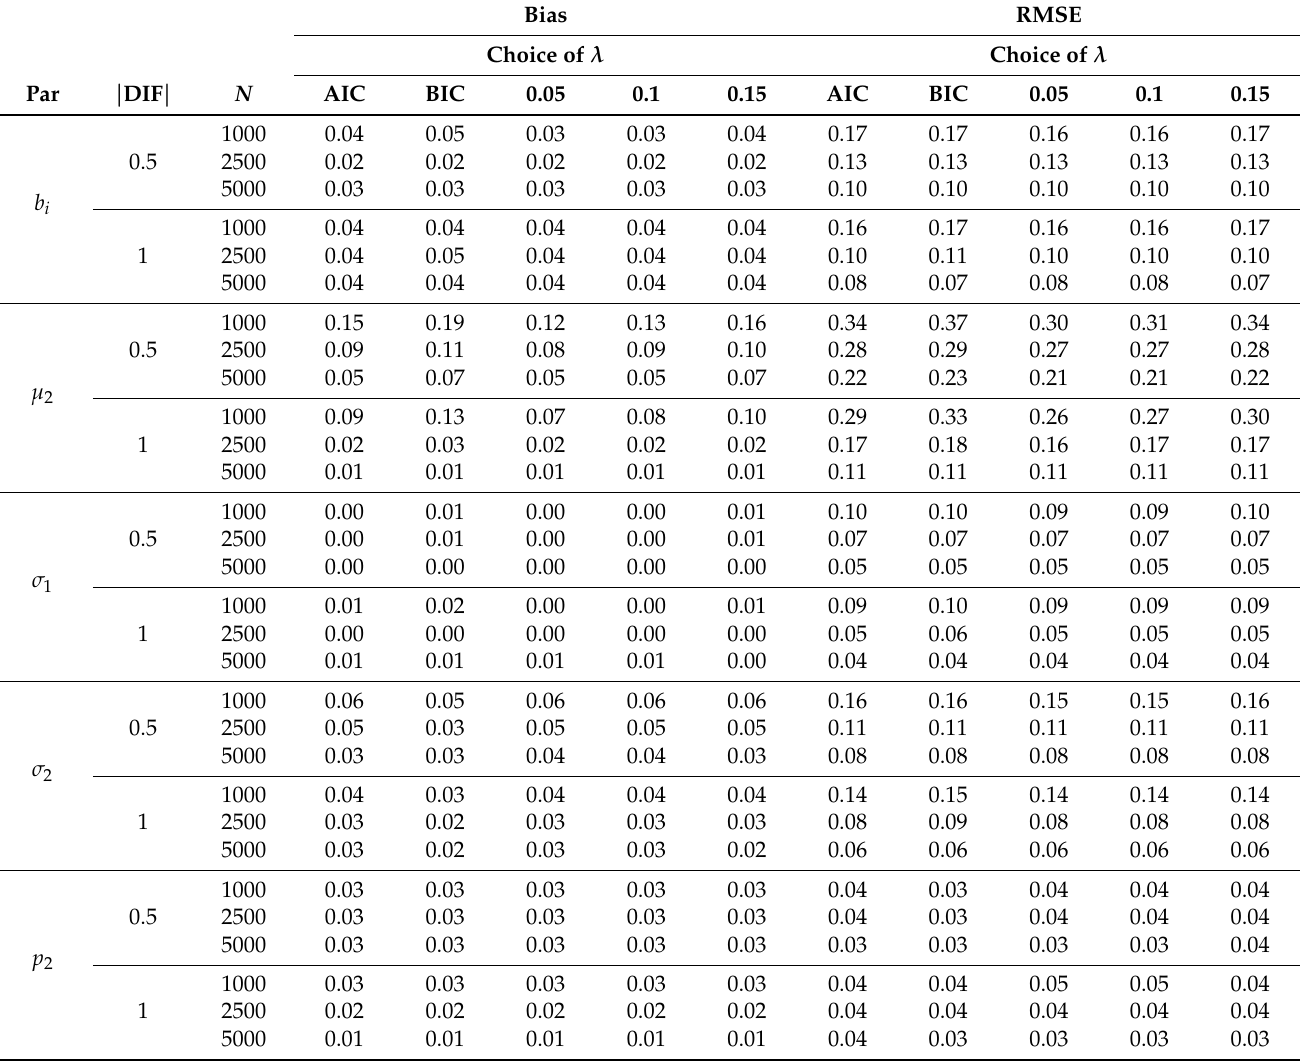
Table 3. Simulation Study 1: Average absolute bias (bias) and root mean square error of model parameters. Bias RMSE Choice of λ Choice of λ